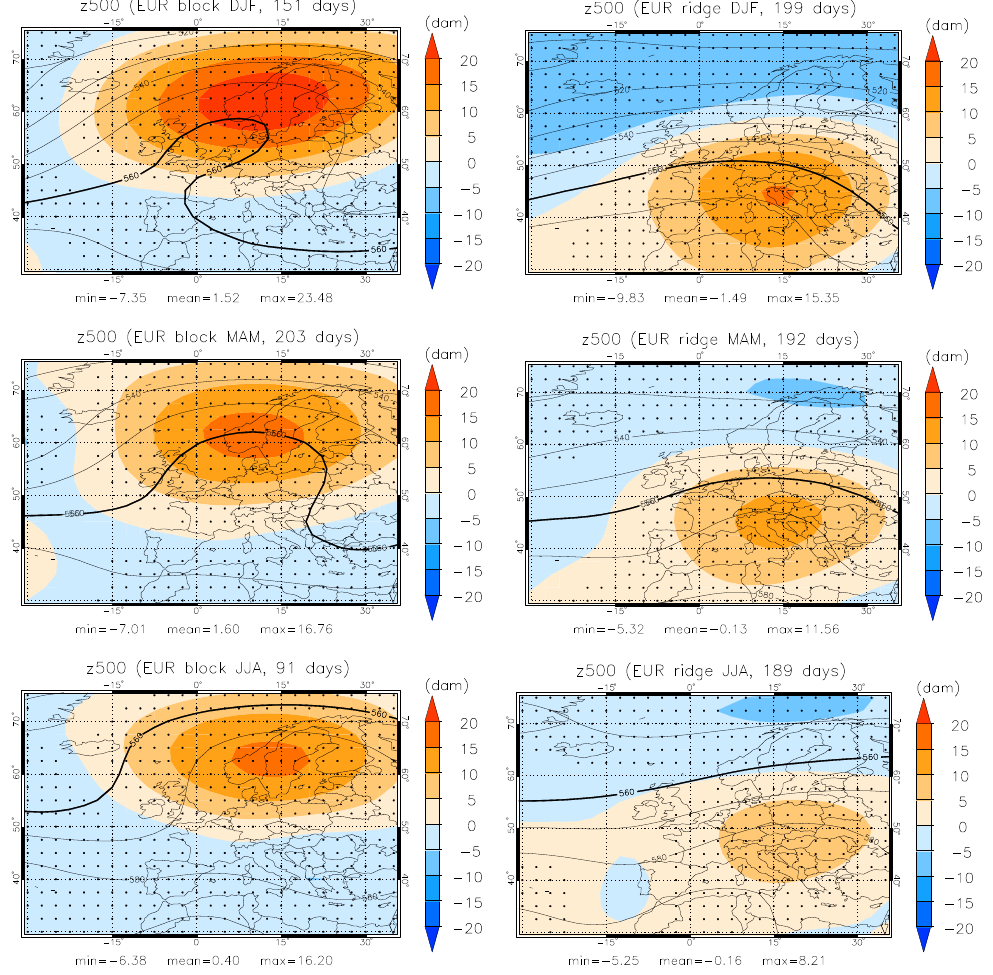
Figure 3. Composites of the daily anomalies with respect to the 1998–2012 climatology (shaded areas) as well as absolute values (black contour lines) of 500hPa geopotential height (Z500) for blocking (left) and ridge (right) centres within the European sector in winter (top), spring (middle) and summer (bottom). Stippling indicates statistically significant anomalies at the 5% level (two-sided t test). All values are in decametres (dam) and the thick line represents the 560 dam isohypse. The total number of days considered is indicated on the top of each